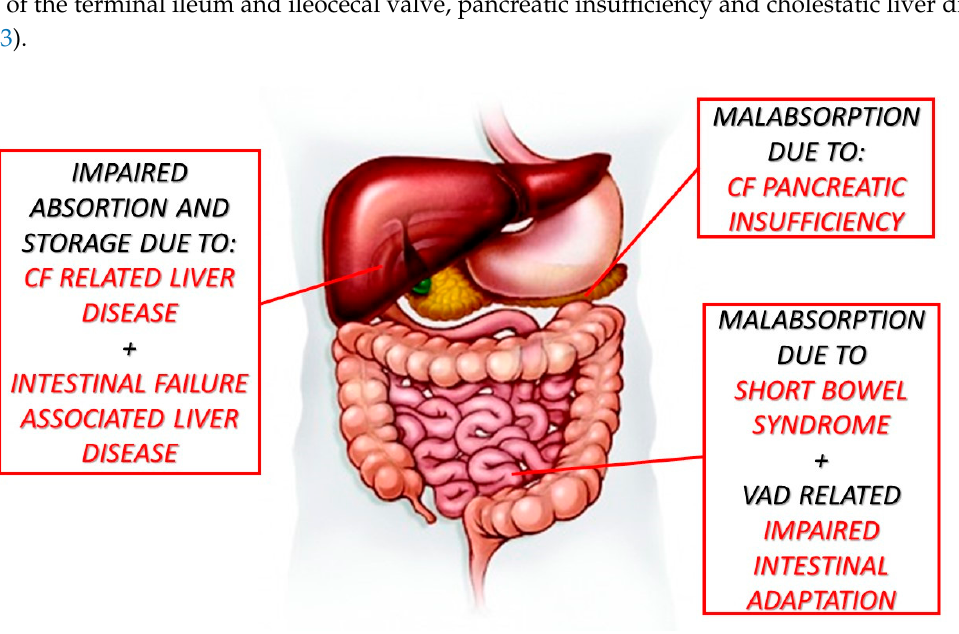
Figure 2. Patient’s full-field electroretinogram (ERG) ( A ) before vitamin A supplementation: decreased scotopic responses in both eyes and depressed photopic response in the left eye; ( B ) after vitamin A supplementation: normal.